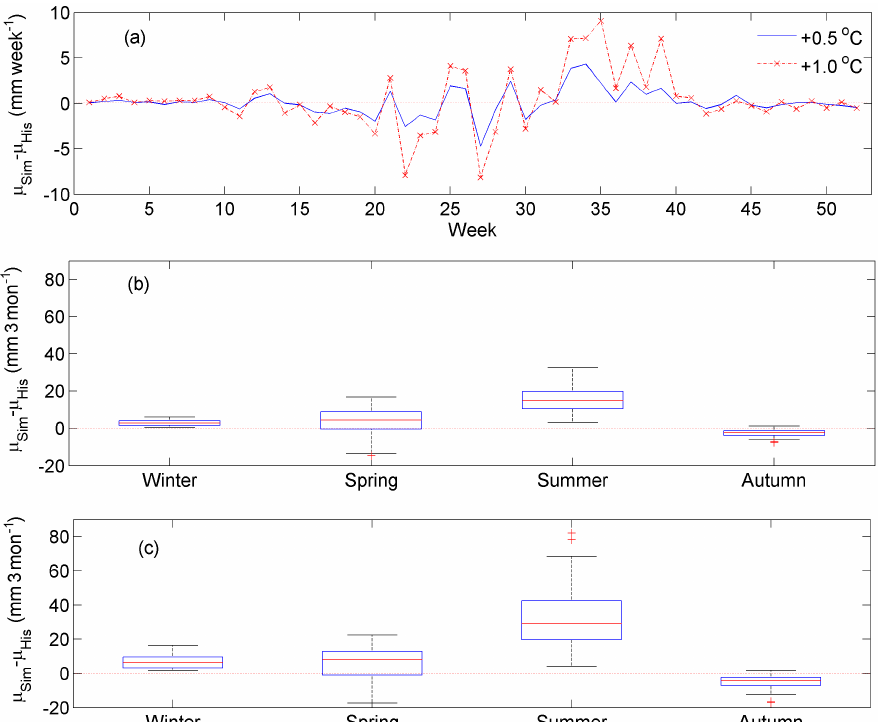
Figure 9. The mean precipitation differences of the observed and simulated data (a) for the weekly precipitation in Buan with a 0.5 ◦ C mean temperature increase, (b) for the seasonal precipitation of all 54 stations with a 0.5 ◦ C mean temperature increase, and (c) for a 1.0 ◦ C mean temperature increase. Note that the mean of the simulated precipitation data is indicated for weekly (a) or seasonal (b, c) time